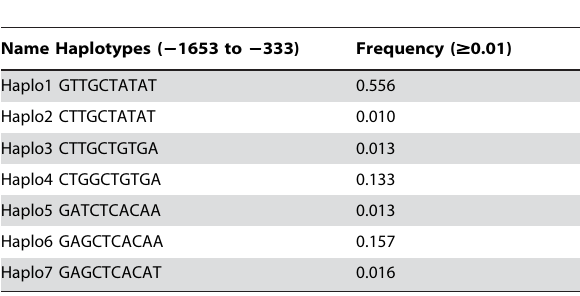
Table 2. Selected haplotypes of the CYP2E1 regulatory region in the Chinese Han populations.